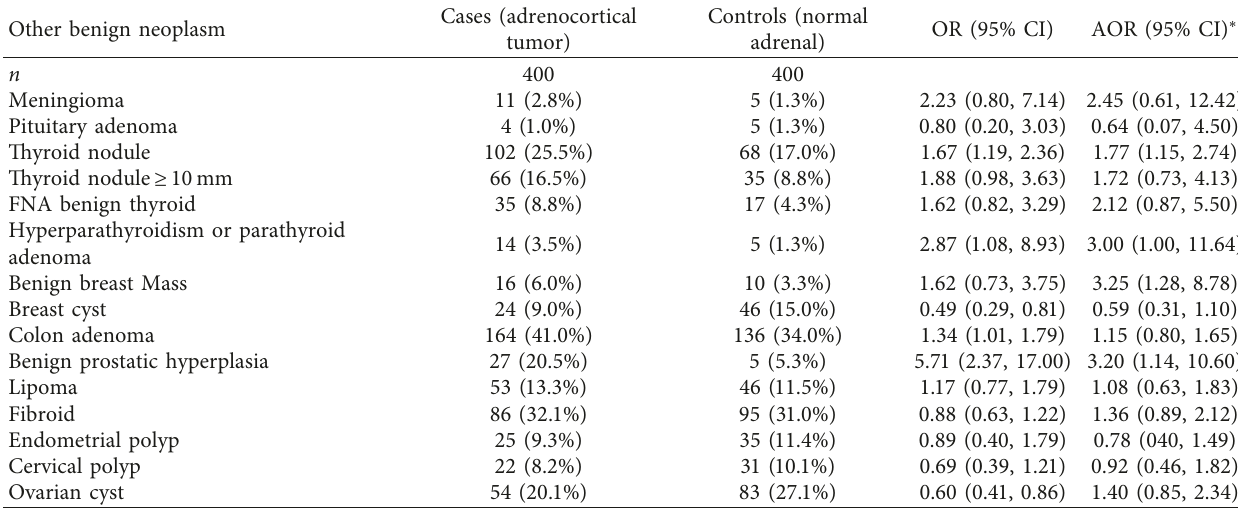
Table 5: Risk for benign neoplasia detected via other modalities.